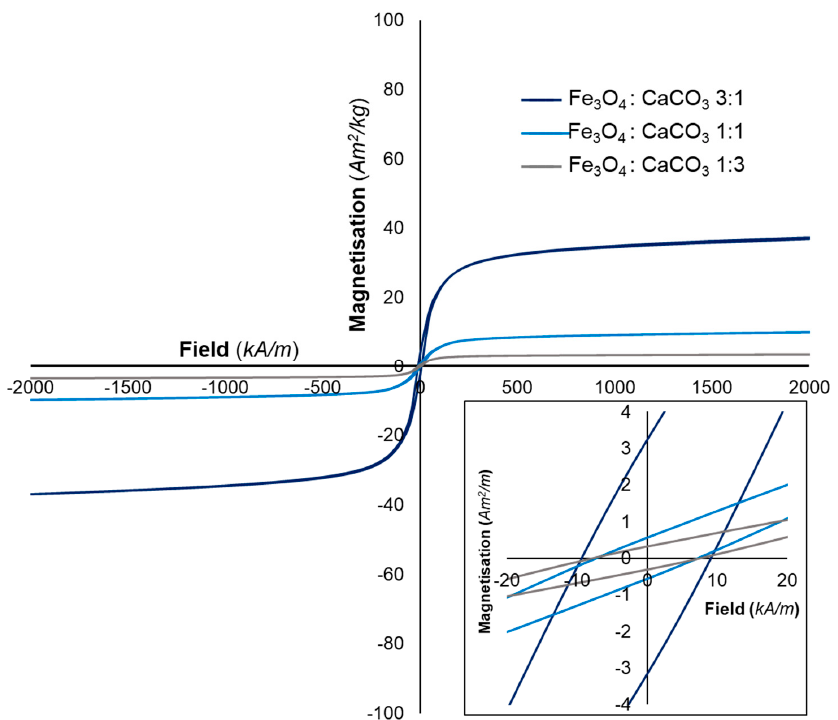
Figure 3. Magnetisation curves for flame-spheroidised Fe 3 O 4 :CaCO 3 (mass ratios 3:1, 1:1 and 1:3; GFS 2.5:2.5) at 26.85 ◦ C. Inset figure provides evidence of remanent magnetisation in all cases. Table 2. Magnetic measurements of fl ame-spheroidised products as a function of precursor to poro- gen mass ratio.